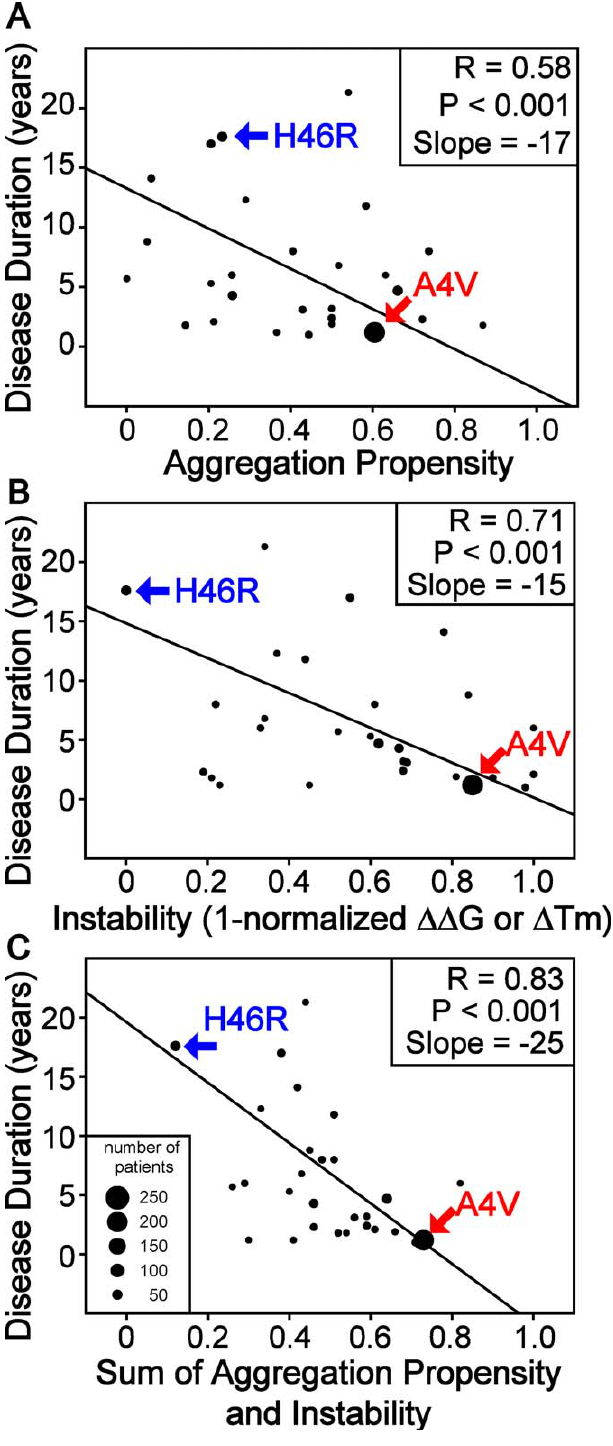
Figure 3. Synergistic Increases in SOD1 Aggregation Propensity and Increases of Instability Are Associated with Decreases in Survival for fALS Patients (Data Weighted by the Number of Patients) (A) An increase in aggregation propensity is associated with a decrease in fALS patient survival. Single point mutations of SOD1 found in fALS patients with corresponding reported stability values in (B) were considered. Aggregation propensities for each fALS mutation were calculated using the Chiti–Dobson equation, normalized such that 0 represents the least and 1 represents the most aggregation